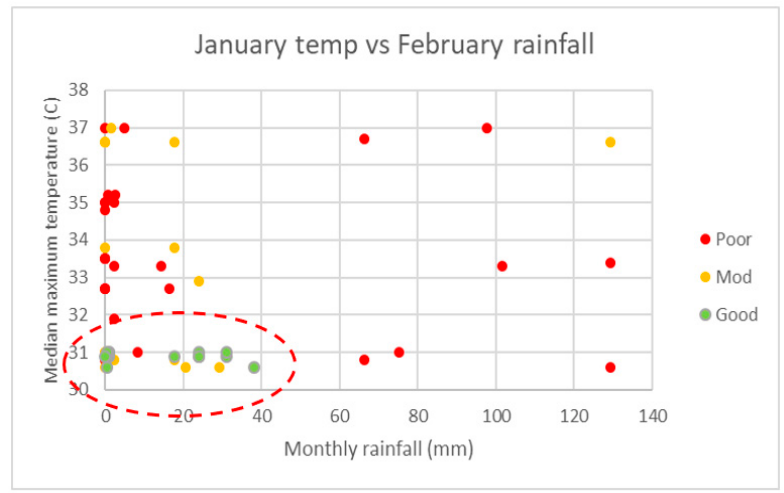
Figure 8. Relationship between January temperature February rainfall and honey harvest (excerpt from Campbell and Fearns [9]).